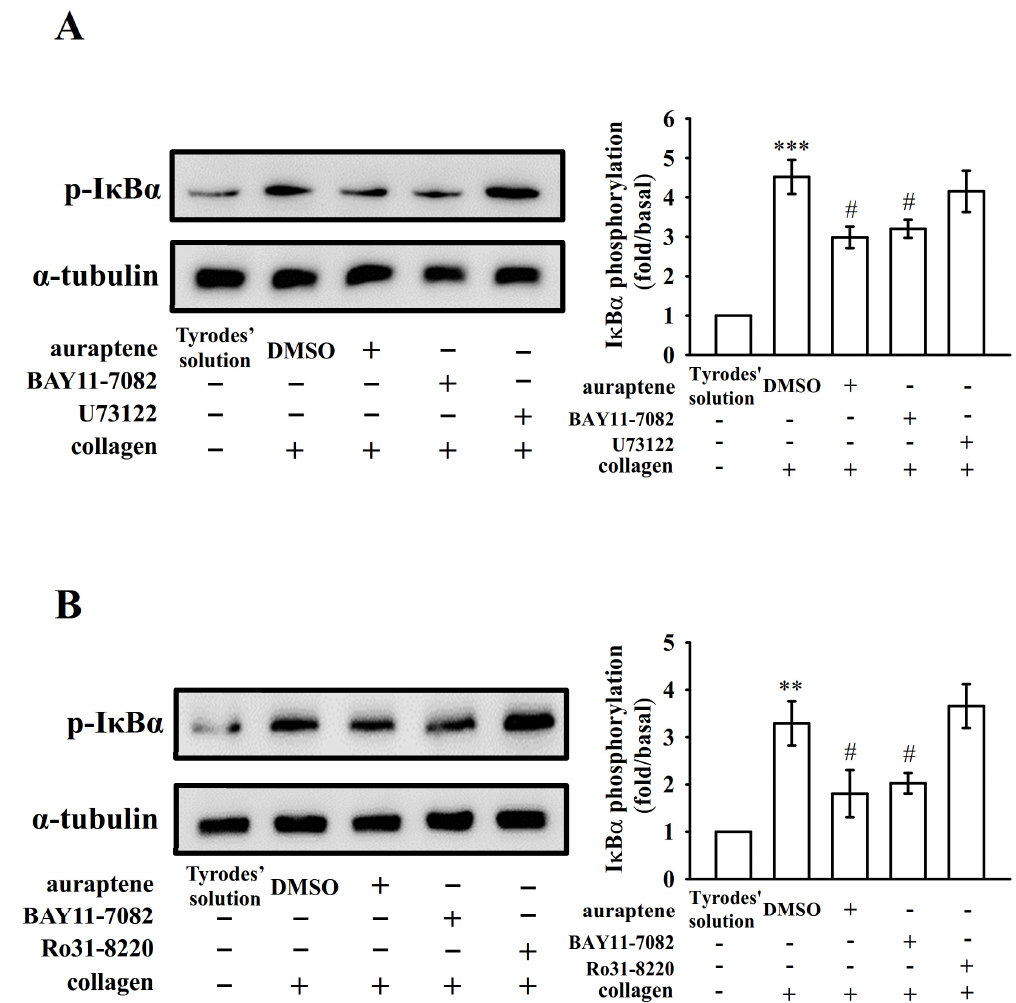
Figure 4. Regulatory profiles of auraptene and PLC / PKC inhibitors on I κ B α protein degradation. Washed platelets were preincubated with 0.1% DMSO, auraptene (60 µ M), BAY11-7082 (10 µ M), U73122 (5 µ M), or Ro31-8220 (2 µ M) and then treated with collagen (1 µ g / mL) to trigger ( A , B ) I κ B α protein phosphorylation. The corresponding statistical data are displayed on the right panel of each figure. Data are given as means ± SEM ( n = 4). ** p < 0.01 and *** p < 0.001, compared with the resting platelets (Tyrode’s solution); # p < 0.05, compared with the 0.1% DMSO-treated group.